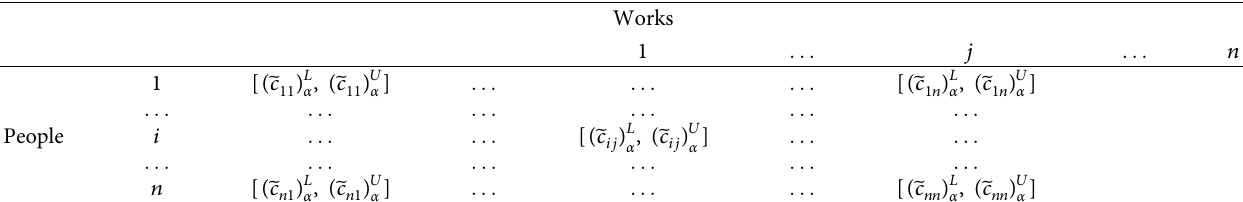
Table 2: Interval assignment